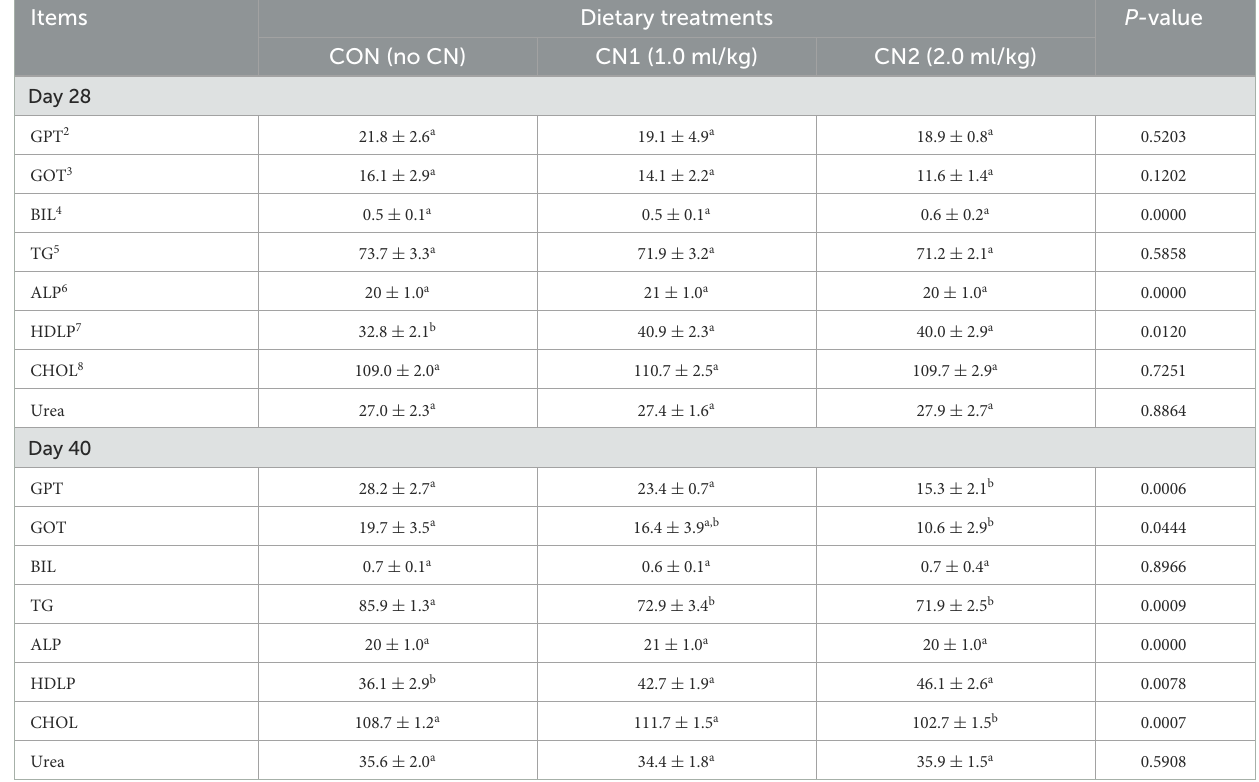
TABLE 2 Dietary curcumin nanospheres (CN) on serum biochemical parameters in finishing pigs for 40 days 1 . Items